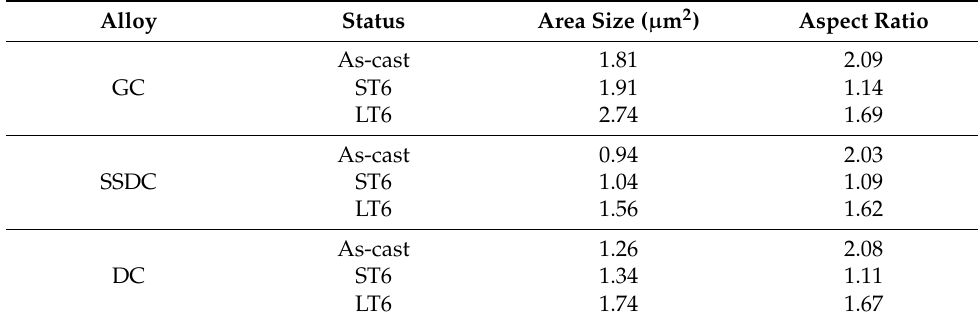
Figure 3. Alloys in different states: ( a ) average eutectic silicon area, ( b ) average aspect ratio of eutectic silicon, ( c ) Gaussian fitting of size frequency of eutectic silicon, ( d ) Gaussian fitting of eutectic silicon aspect ratio frequency. Table 2. Si area sizes and aspect ratio of Si